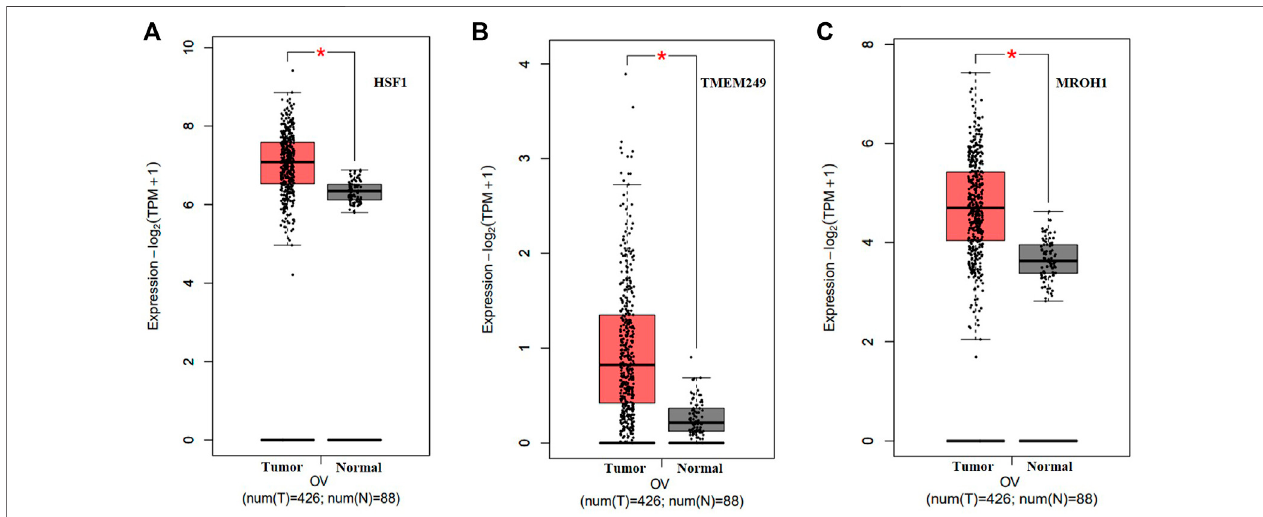
FIGURE5| mRNAlevelsofthreegenesrelated toNACresistanceinserousovariancarcinoma(SOC) onGeneExpressionPro fi lingInteractiveAnalysis2(GEPIA2). Upregulated expression of (A) HSF1, (B) TMEM249, and (C) MROH1 in mRNA levels signi fi cantly for SOC compared with that for normal tissue by GEPIA2 was observed (*: p < 0.05